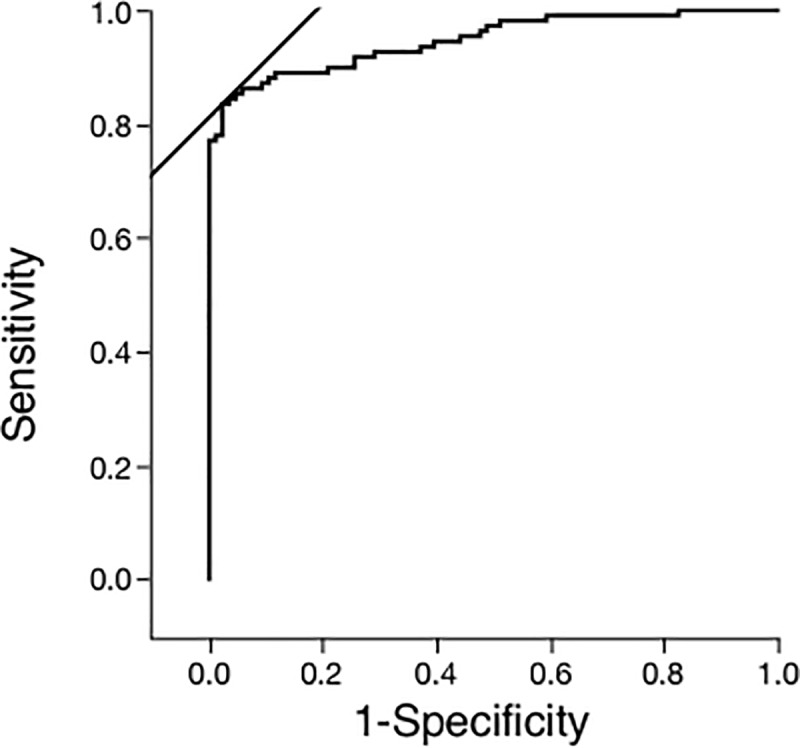
Utility of serum VEGF-D for diagnosing LAM was determined using a receiver operative characteristics (ROC) curve analysis comparing sensitivity and specificity.The area under the curve and the cut-off level were 0.94 and 645.0 pg/ml, respectively.